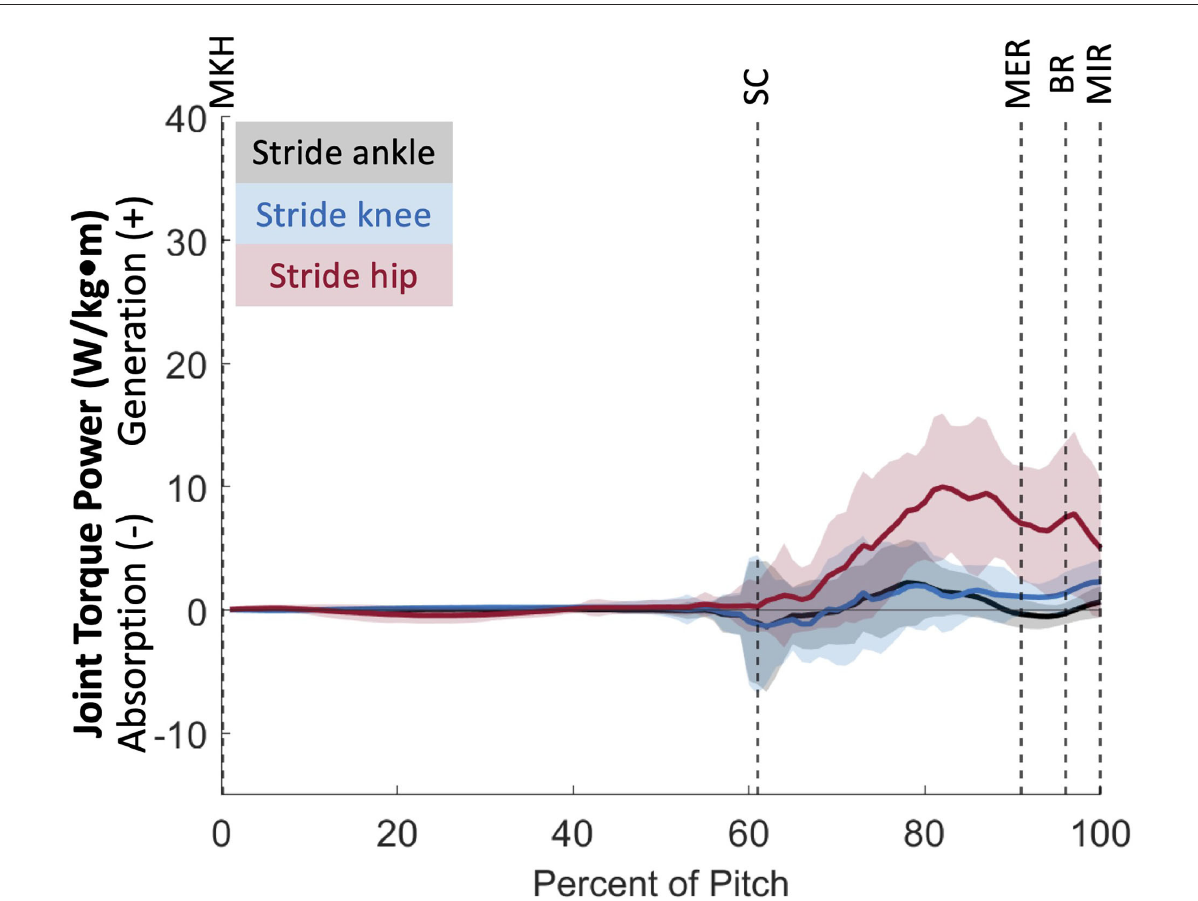
FIGURE8 Mean ± SD joint torque power for the joints of the stride leg (black = ankle, blue = knee, red = hip) for the duration of the pitch from maximum knee height (MKH) to maximum internal rotation